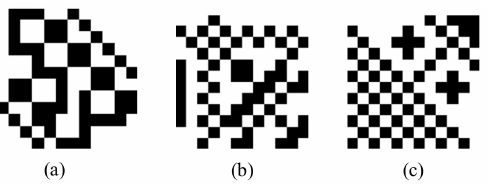
Figure 5. An example of textured patterns used in 2LQR codes. There are three classes of textured patterns here. ( a ) The first class of textured pattern P 1 . ( b ) The second class of textured pattern P 2 . ( c ) The third class of textured pattern P 3